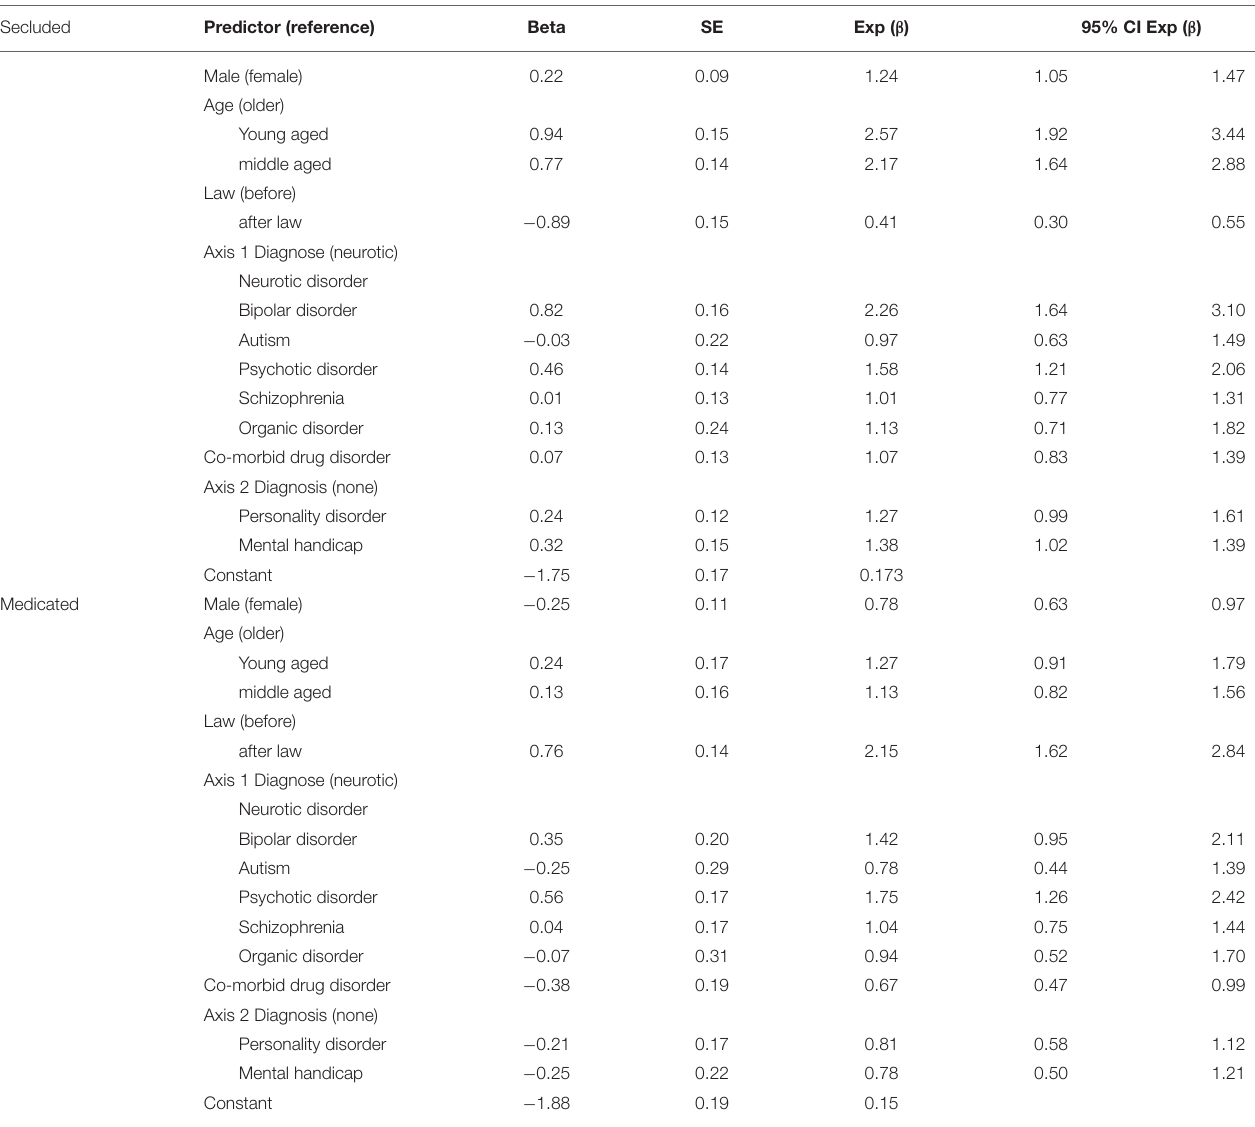
TABLE 2 | Logistic regression findings.